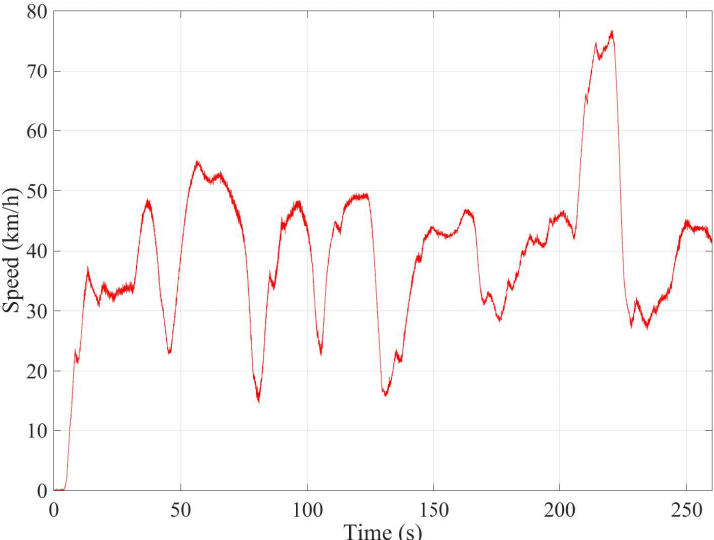
Figure 6. Test 3: Vehicle speed